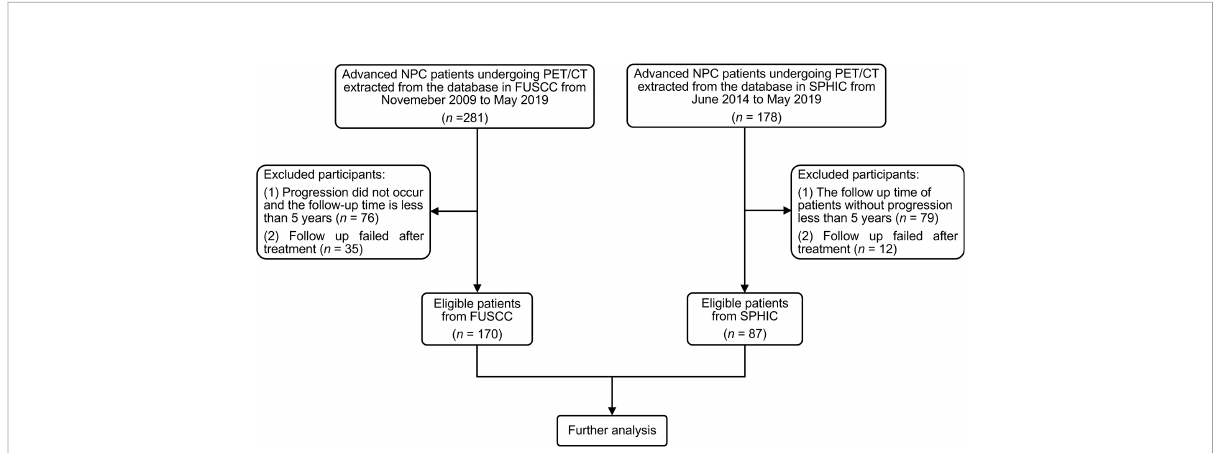
FIGURE 2 The fl owchart of patient inclusion and exclusion. NPC, nasopharyngeal carcinoma; FUSCC, Fudan University Shanghai Cancer Center; SPHIC, Shanghai Proton and Heavy Ion